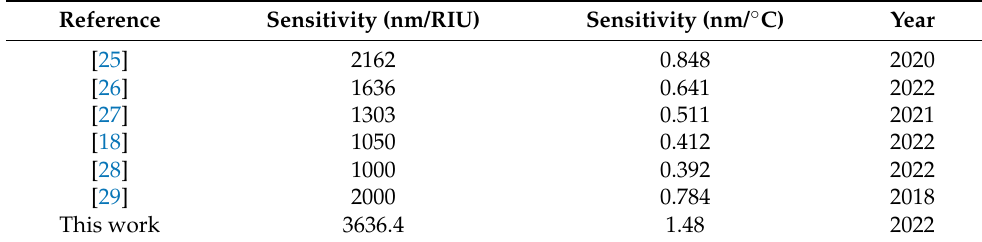
Table 4. Comparison of sensitivity with recent literature. Sensitivity data converted to temperature sensitivity use ethnol as the